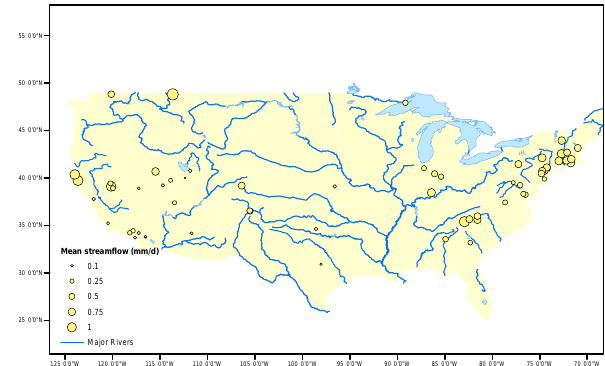
Fig. 1. Locations of sample watersheds (circles, n = 61) within the coterminous United States. Circle size shows mean streamflow per unit area, an indication of local moisture